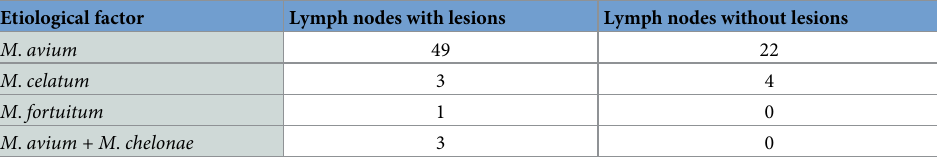
Table 1. Number of submandibular lymph nodes from which M . avium was